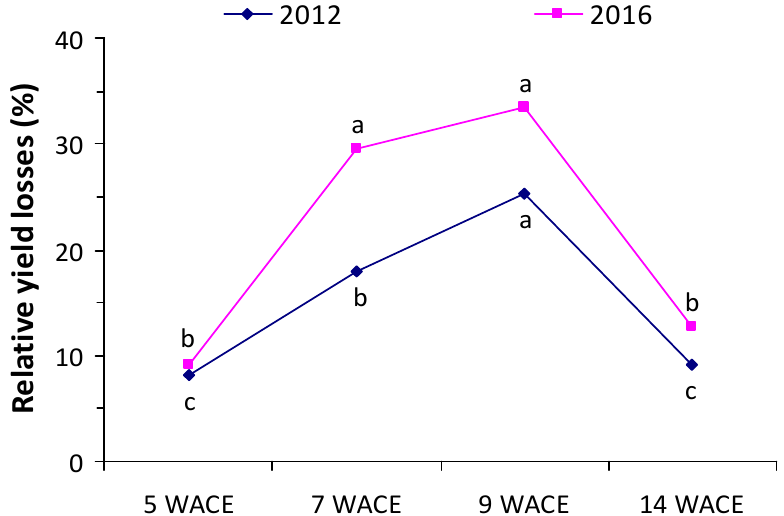
Figure 8. Relative yield loss (RYL) index at various weeks after crop emergence (WACE) in the first and second growing seasons. Different letters in each growing season indicate statistically significant differences at p < 0.05.